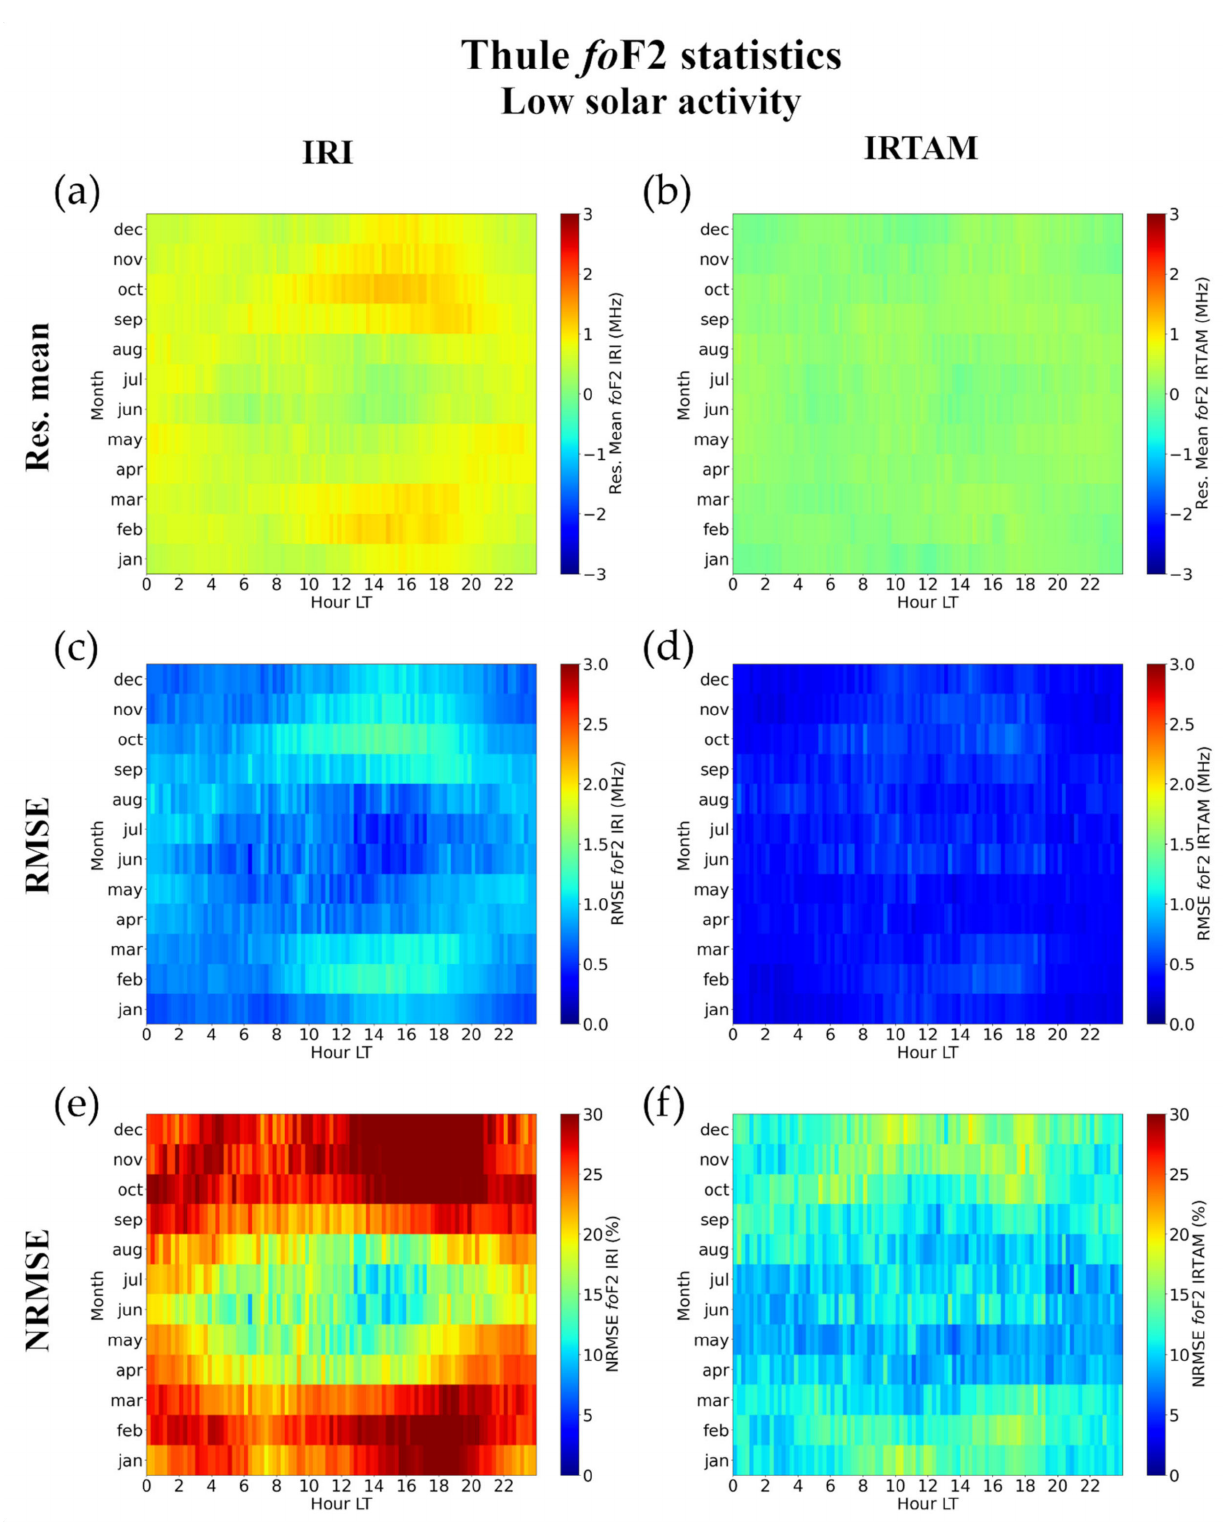
Figure 16. Same as Figure 4 but for